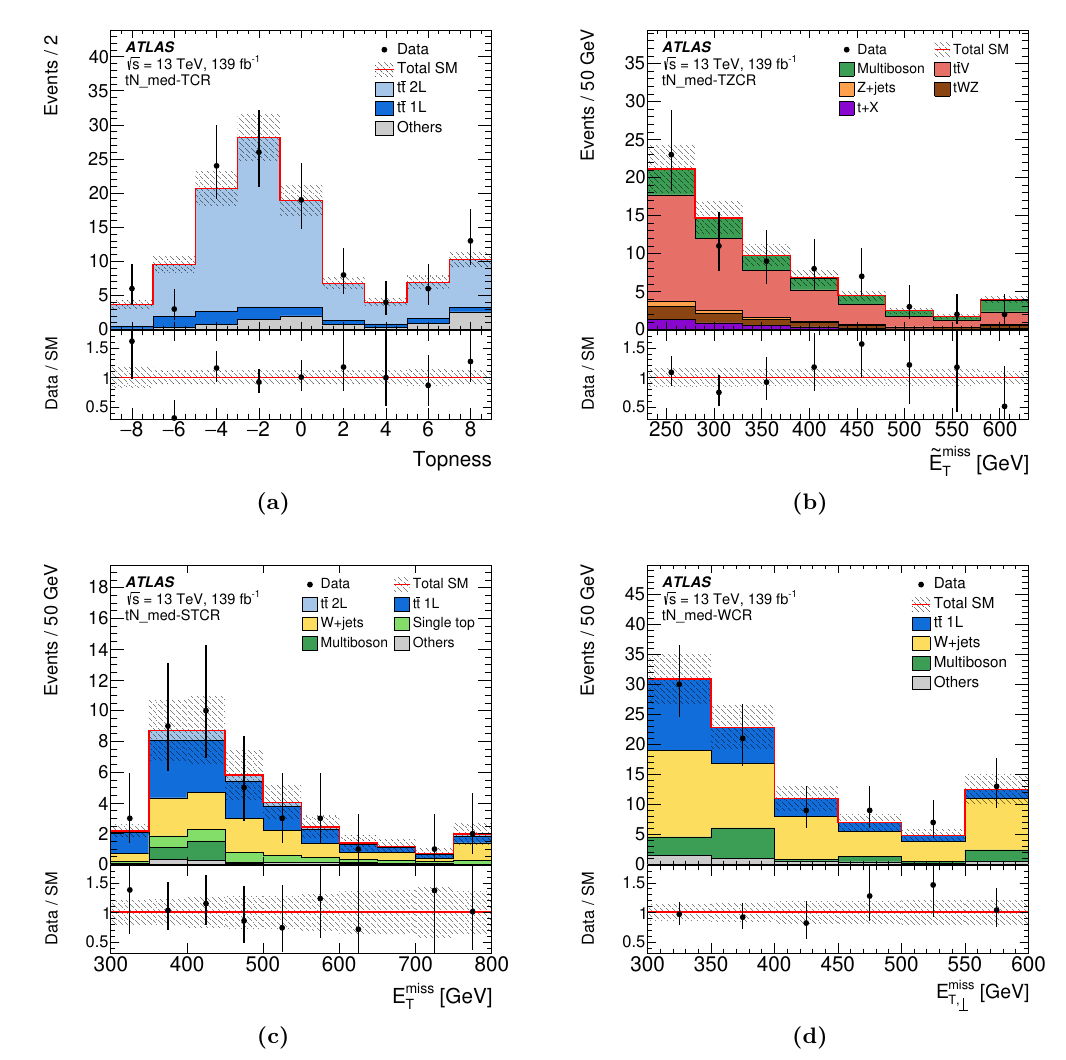
Figure 3. Selected kinematic distributions in tN_med CRs: (a) topness in the TCR, (b) ˜ E miss the TZCR, (c) E miss in the STCR, (d) E miss in the WCR. The distributions shown are post-fit, i.e. T T , ⊥ each background is scaled by a normalisation factor obtained from a background-only likelihood fit to the CRs (see table 14). The hatched area around the total SM prediction and the hatched band in the Data/SM ratio include all statistical and systematic uncertainties. The last (first) bin contains overflows